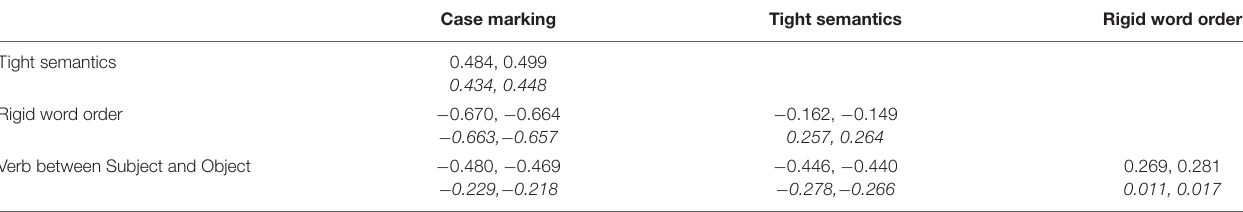
TABLE A1 | 95% confidence intervals around Spearman’s correlation coefficients based on 1,000